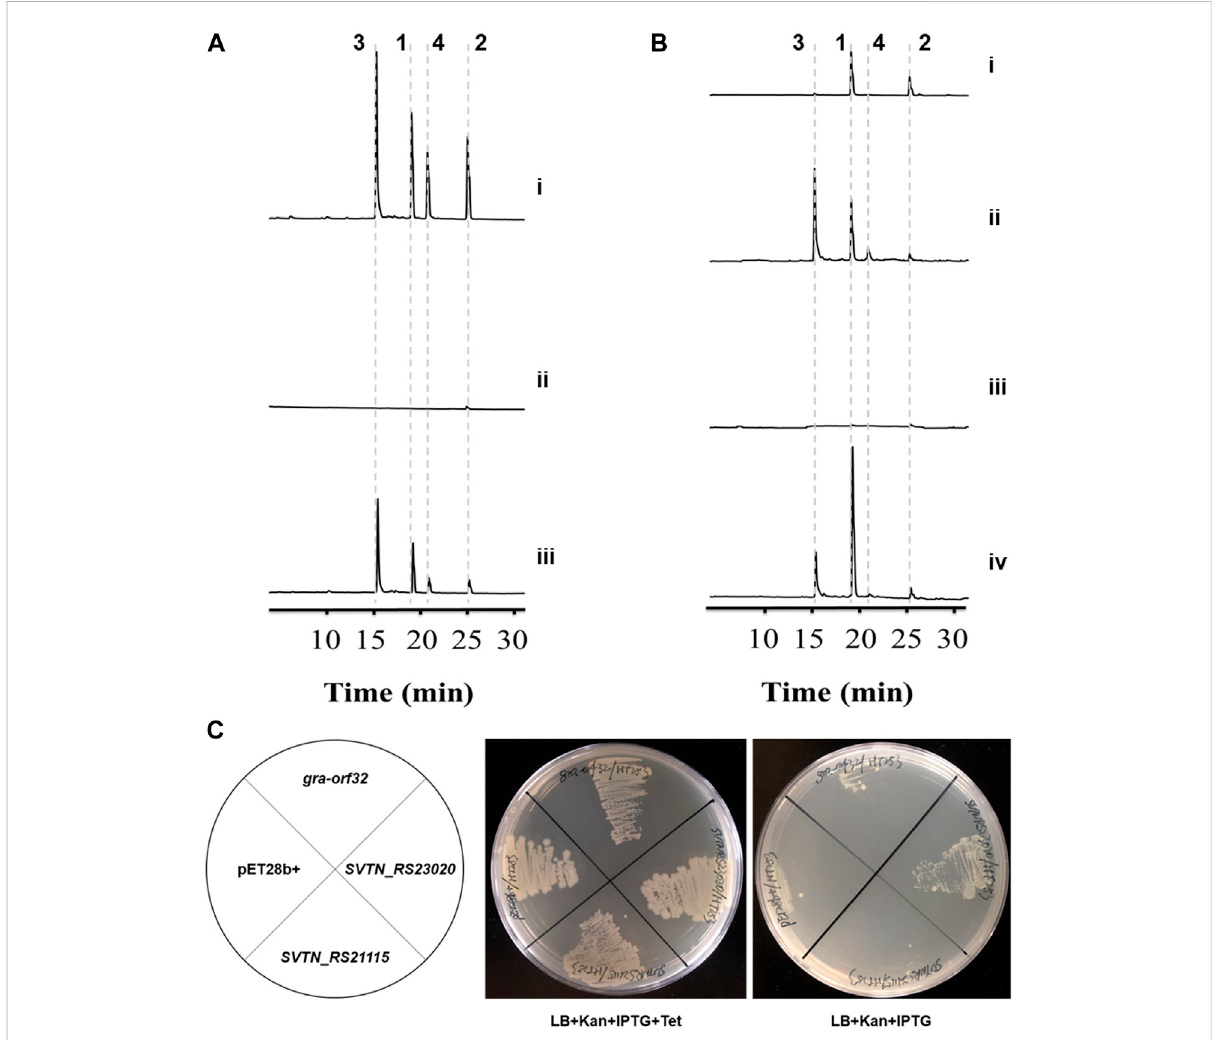
FIGURE 2 Inactivation, complementation and heterologous expression of the Sfp-type PPTase gene gra-orf32 . 1 , granaticin; 2 , granaticin B; 3 , granaticinic acid; 4 ,granaticinic acidB.TheUVabsorbance datawerecollectedatthewavelength of520 nm. (A) HPLCmetabolic pro fi lingofthein- frame deletion and complementation strains of S. vietnamensis . Strains were rotationally cultivated in liquid YEME for 3 d i, the wild-type strain GIMV4.0001; ii,thein-framedeletionmutant Δ gra-orf32 ;iii,thecomplementationstrain Δ gra-orf32 : gra-orf32 . (B) HPLCmetabolicpro fi lingof culturesofthemutant Δ gra-orf32 fromISP2andYEME plates.i,thedeletionmutant Δ gra-orf32 on ISP2plate; ii,thewild-type strainGIMV4.0001 on ISP2plate;iii,thedeletionmutant Δ gra-orf32 onYEMEplate;iv,thewild-typestrainGIMV4.0001onYEMEplate. (C) Heterologousexpressionof gra- orf32 in the conditional ACPS-de fi cient E. coli mutant HT253. The growth of HT253 is tetracycline-dependent. SVTN_RS23020 is the putative FAS ACPS gene in S. vietnamensis . SVTN_RS21115 is another ACPS-type gene located in a NRPS-like cluster in S. vietnamensis . All strains could grow normally on plates with kanamycin, IPTG and tetracycline, but only the strain carrying SVTN_RS23020 was viable on plates without